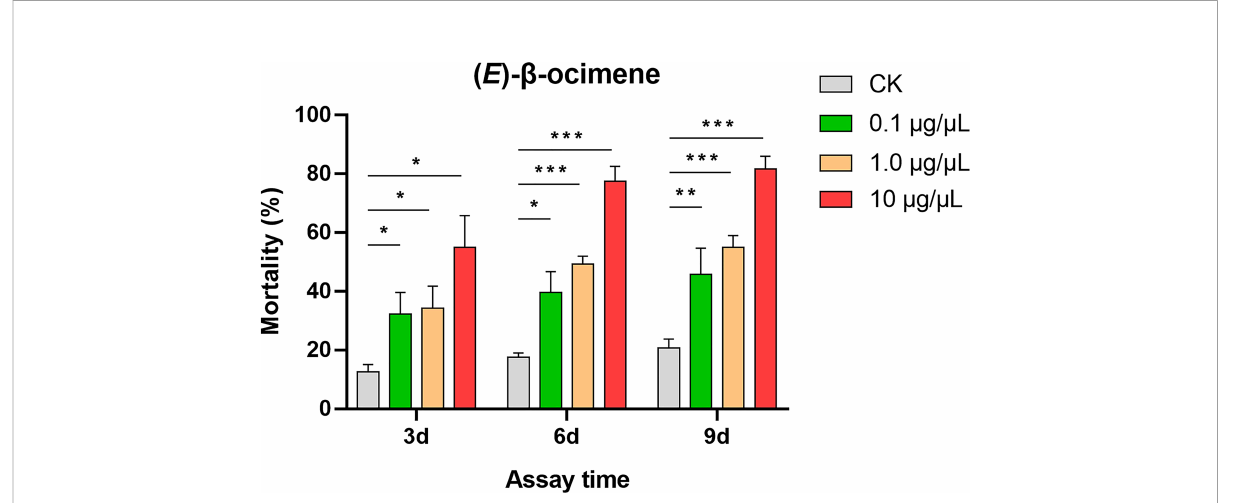
FIGURE 7 Larval mortality of Spodoptera litura caused by ( E )- b -ocimene. Data were tested for differences using Student ’ s t -test (* P < 0.05; ** P < 0.01; *** P < 0.001).